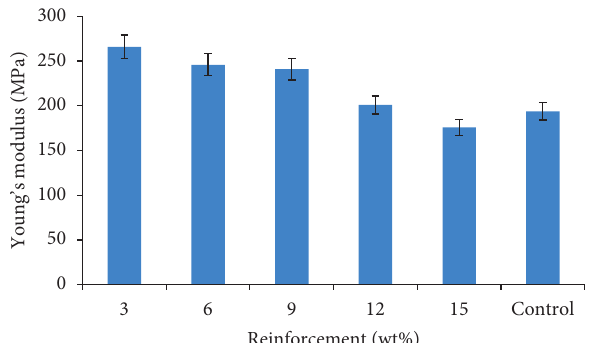
Figure 4: Variation in Young’s modulus of the developed com- posites and the control.